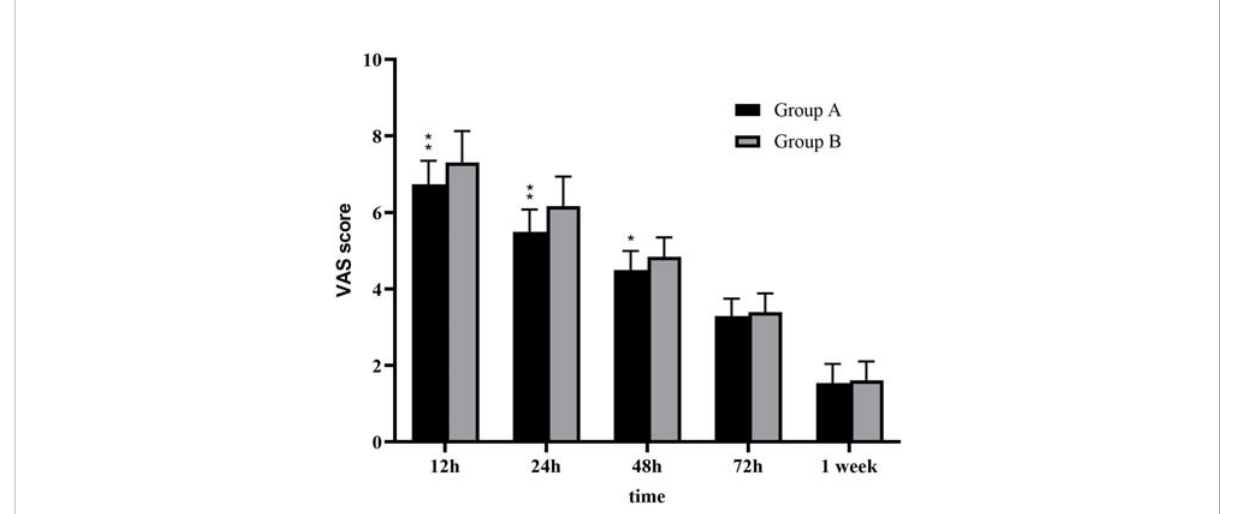
FIGURE 2 Postoperative visual analogue scale (VAS) pain scores. The postoperative pain scores in group B after surgery were signi fi cantly higher compared with that in group A ( P < 0.05).**: P < 0.001 *: P <